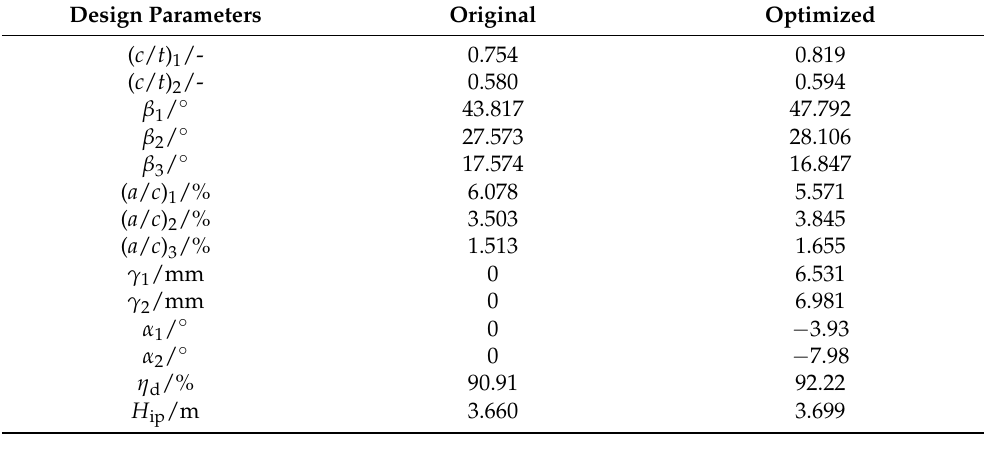
Table 5. Comparison of the parameters between the original and optimized models. Design Parameters